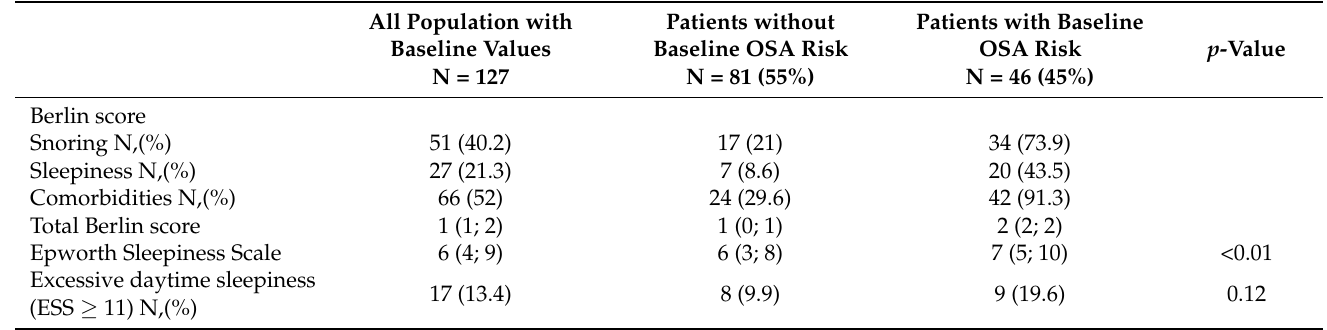
Table 2. Initial measures of Berlin and Epworth Sleepiness Scale for all